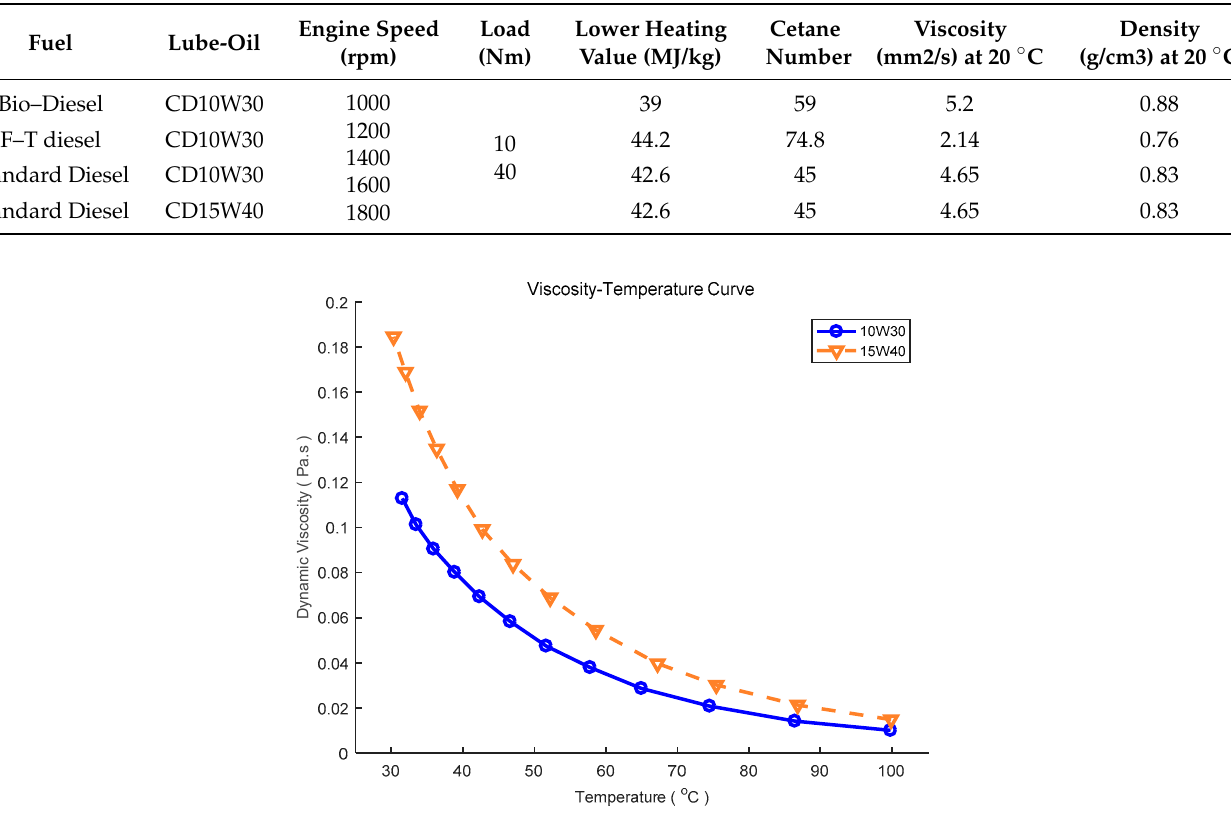
Table 2. Engine operating conditions and the fuels properties tested.